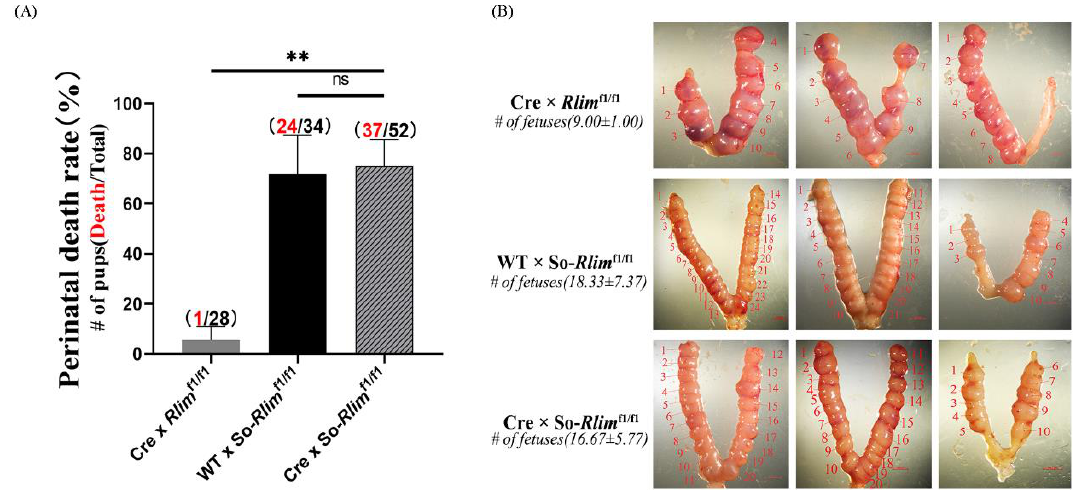
Figure 6. Superovulation in the mother mice increased the perinatal mortality of pups. ( A ) Effects of superovulation in the mother mice on the perinatal death rate of the offspring. Red marks the total number of pups that died during the perinatal period and black marks the total number of pups that were born. ( B ) Effects of superovulation in the mother mice on the implantation of E7.5–E8.5 fetuses. ns represents nonsignificant difference at p > 0.05; ** represents p < 0.01.